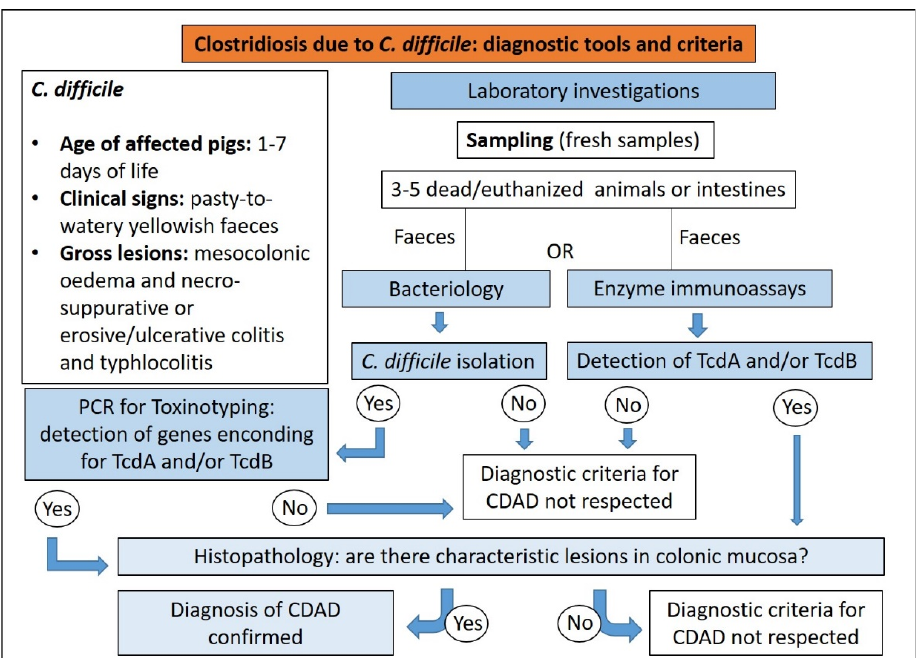
Figure 14. Diagnostic algorithm for the diagnosis of clostridiosis due to C. difficile in pigs.